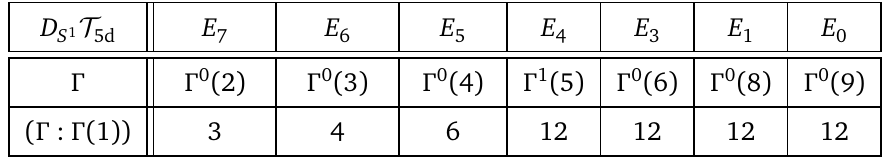
Table 2: Modular groups for the massless D They are all congruence subgroups. The massless CB for E